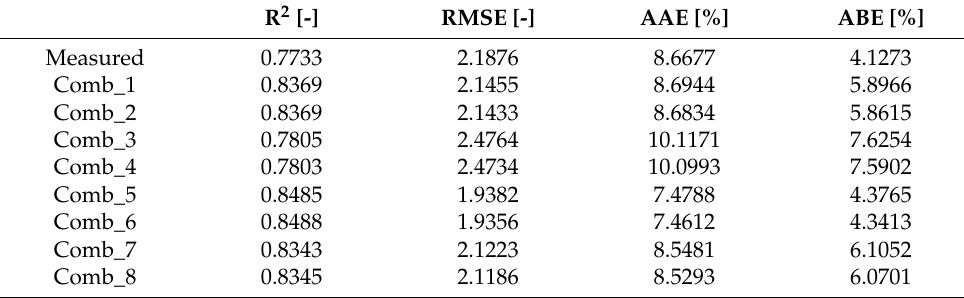
Table 8. Summary of HHV prediction